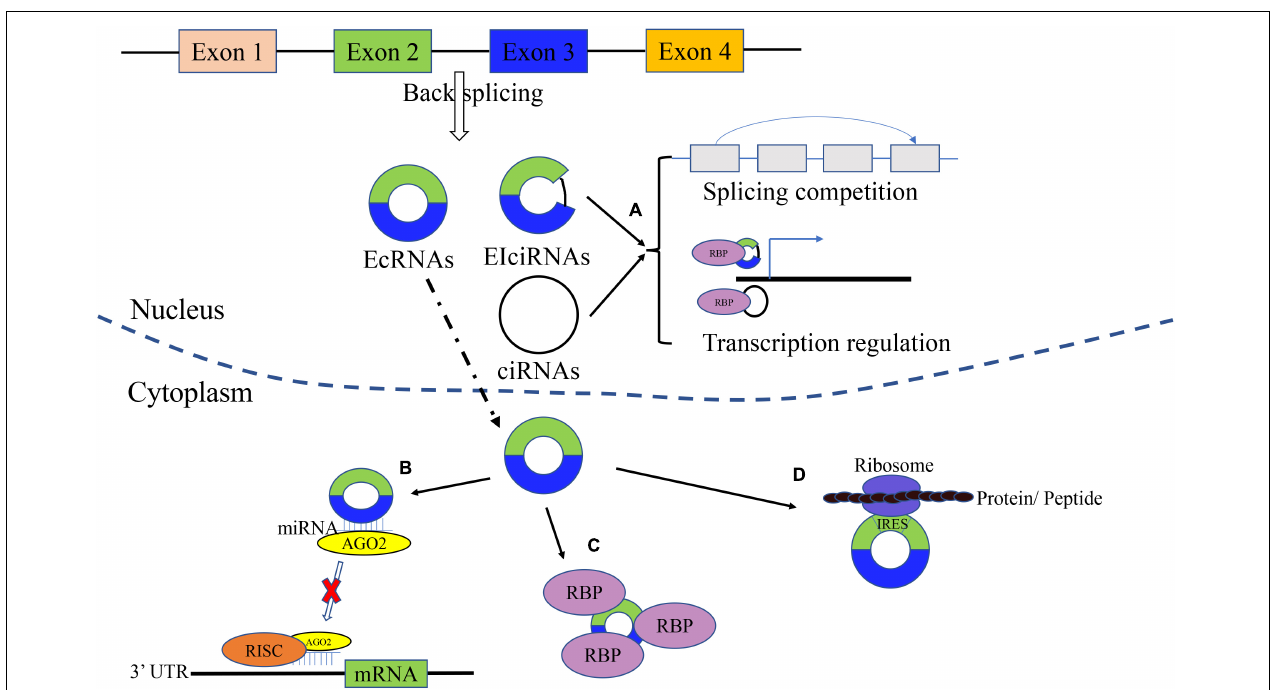
FIGURE 1 | Biogenesis and molecular function of circRNAs. circRNAs are generated from exonic and/or intronic sequences of primary transcripts by back-splicing. The main types of circRNAs includes EcRNAs, EIciRNAs, and ciRNAs. (A) Gene translation regulation. circRNA can regulate related downstream gene and parental gene transcription. (B) microRNA sponge. circRNAs can act as microRNA sponges and suppress the effects of microRNA on target genes. (C) Binding RBP. By interaction with RBP, circRNAs can inhibit/enhance protein function, and promote the colocalization of protein. (D) Translation function. circRNA can be translated into